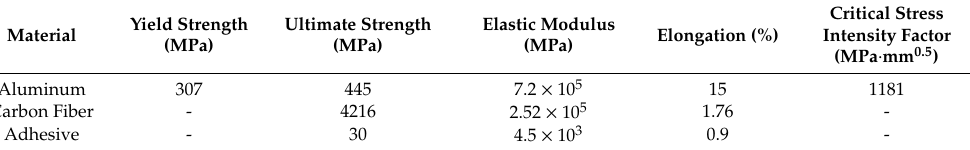
Figure 3. Analytical illustration of an off-centrally cracked strip. Table 1. Mechanical properties of test materials.